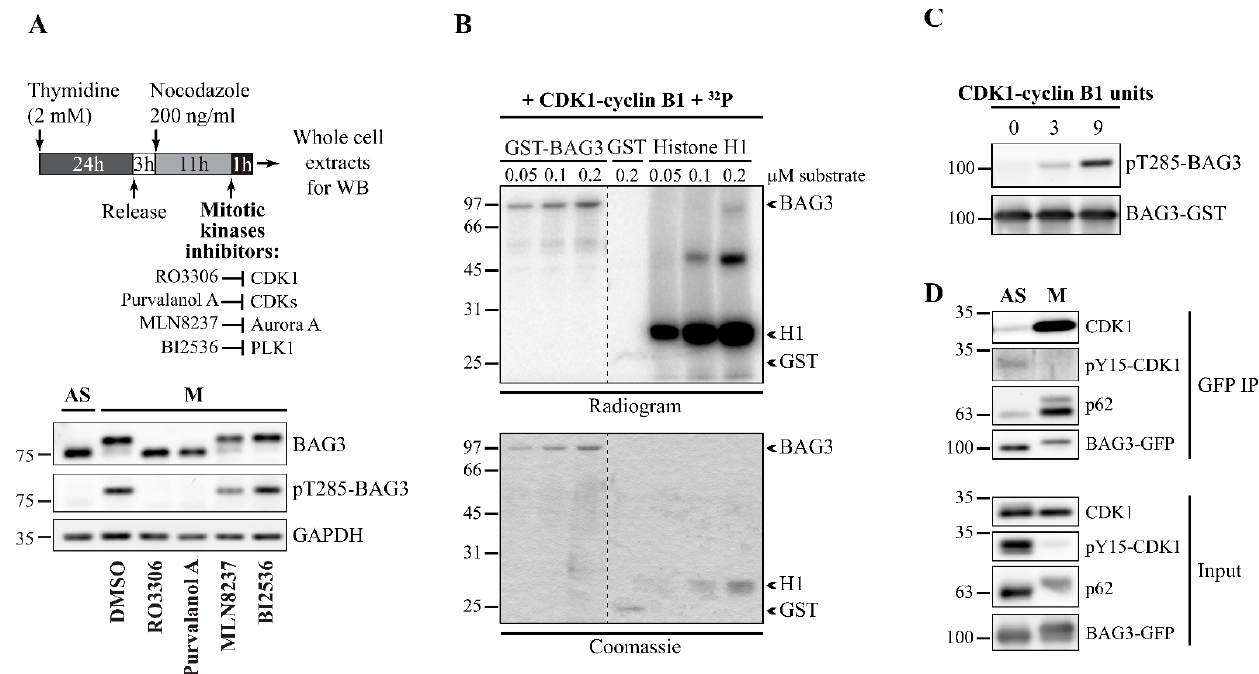
Figure 2. CDK1 regulates BAG3 phosphorylation dynamic at T285. ( A ) Schematic of the protocol used. Extracts were prepared from mitotic HeLa-RFP-H2B incubated for 1 h in the presence of chemical inhibitors of the following kinases: RO3306 (CDK1, 8 μ M), Purvanolol A (CDKs, 10 μ M), MLN8237 (Aurora A, 1 μ M), and BI2536 (PLK1, 1 μ M) or the vehicle only (DMSO); mitotic cells were collected by a mitotic shake-off. Immunoblotting was performed as indicated; GAPDH: loading control. See also Figure S2. ( B ) Autoradiogram showing phosphorylation of recombinant GST-BAG3 by a purified CDK1-cyclin B1 complex in the presence of 32 P-ATP; positive control: Histone H1; negative control: GST. ( C ) Immunoblotting of in vitro phosphorylated BAG3 using the phospho-specific pT285-BAG3 antibody; total levels of GST-BAG3 are shown. ( D ) BAG3-GFP IPs were pre- pared from asynchronous (AS) or mitotic HeLa-Flp-In T-REx- BAG3-GFP WT (nocodazole-arrested) transfected with BAG3- specific siRNA (siBAG3 [3 ′ UTR_1], 48 h) and treated with doxycycline to induce BAG3-GFP expression (1 ng/mL, 16 h). West- ern blots of the GFP IPs were performed as indicated; levels of CDK1, pY15-CDK1 (inactive CDK1), p62, and BAG3-GFP in total cell extracts are shown (Input).